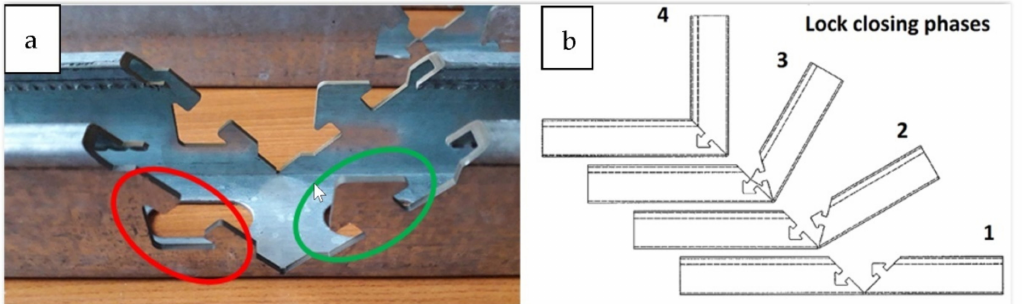
Figure 5. The concept of the console bending process with a lock: ( a ) the laser cut lock outline; ( b ) console assembly process: 1–4 subsequent bending